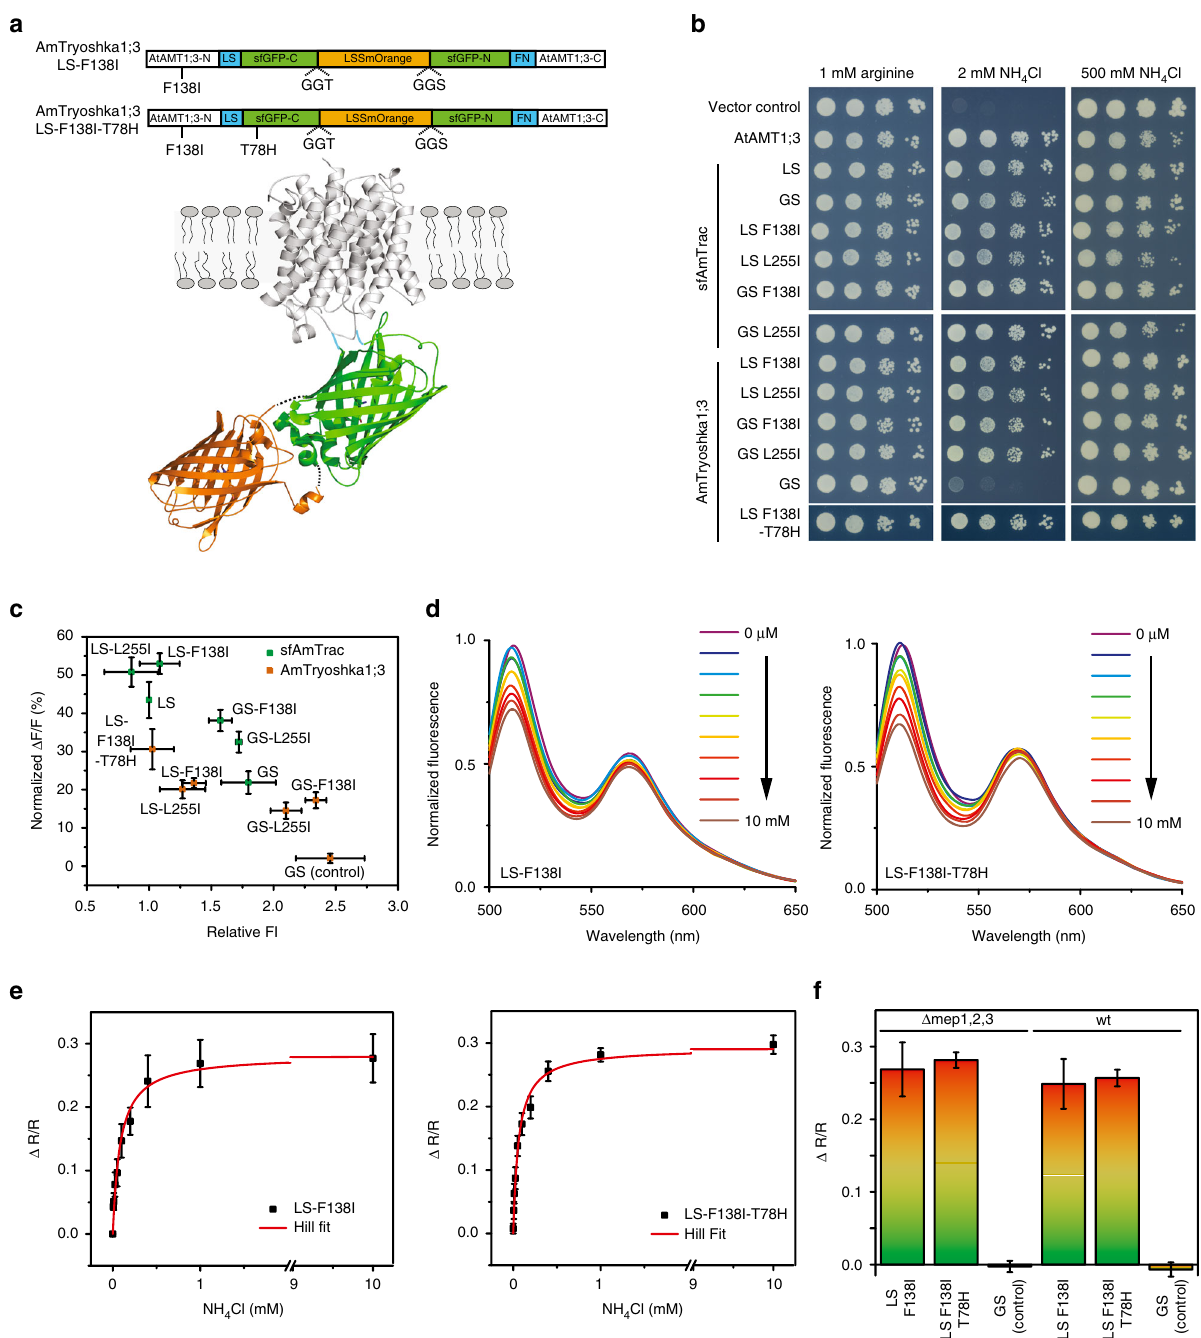
Fig. 5 AmTryoshka characterization in yeast cell cultures. a Schematic representation of AmTryoshka1;3, with LSSmOrange nested inside the native C- and N-termini of sfGFP and then sandwiched between the native N and C termini of AtAMT1;3. The sensors contained the F138I suppressor mutation in the N-terminal portion of the AtAMT1;3 domain and the LS/FN residues fl anking the sfGFP. AmTryoshka1;3-LS-F138I-T78H additionally contains the T78H mutation in the sfGFP domain. Cartoon illustrates only one subunit of the AtAMT1;3 trimer. b Complementation of the yeast Δ mep1,2,3 mutant transformed with indicated sensors grown on solid media with indicated N sources. Arginine served as growth control. The columns of plated cells represent 1:10 dilutions (a minimum of three biological replicates were analyzed). c Relative FI (normalized to sfAmTrac-LS = 1) and fl uorescence change in the green channel ( λ exc 440 nm) after addition of 1 mM NH 4 Cl (mean ± s.d. from biological replicates with n = 4 for AmTryoshka1;3-LS-F138I, LS-L255I, GS-F138I, -GS-L255I, n = 3 for rest of constructs). d Steady-state emission spectra of AmTryoshka1;3-LS-F138I and -T78H with λ exc 440 nm and treatment with NH 4 Cl at the different concentrations (0, 6.25, 12.5, 25, 50, 100, 200, 400 μ M, 1 mM or 10 mM). Spectra were normalized to maximal intensity. ( e ) Titration of Δ R/R (R = FI 510nm /FI 570nm ) of AmTryoshka1;3-LS-F138I and -T78H ( black squares ) and Hill fi t ( red line ). Data were corrected for fl uorescence bleed-through (bleed-through factor 0.08) and normalized to water-treated controls (mean ± s.e.m. from biological replicates with n = 4 for LS-F138I, n = 6 for LS-F138I-T78H ). f Fluorescence response ( Δ R/R) of Δ mep1,2,3 or wild type (wt) transformed with AmTryoshka1;3-LS-F138I, -T78H or the non- responsive control AmTryoshka1;3-GS (mean ± s.e.m. from biological replicates with n = 4 for LS-F138I, n = 5 for LS-F138I-T78H, n = 3 for GS of Δ mep1,2,3 transformation, n = 5 for LS-F138I, n = 4 for LS-F138I-T78H, n = 4 for GS of wild-type